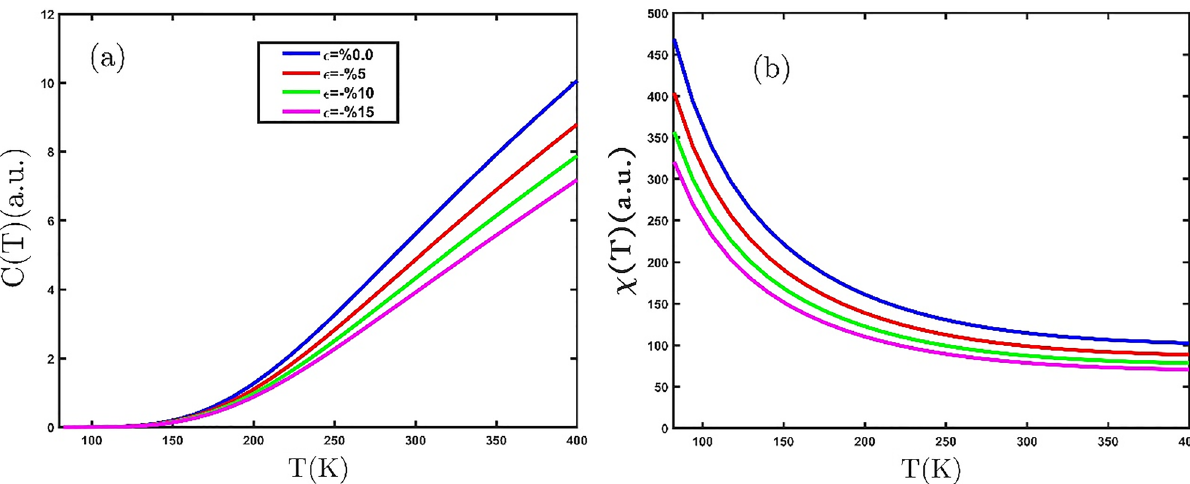
Figure 6. ( a ) The electronic heat capacity and ( b ) magnetic susceptibility of the GeCH 3 SL as a function of the temperature for different compressive biaxial